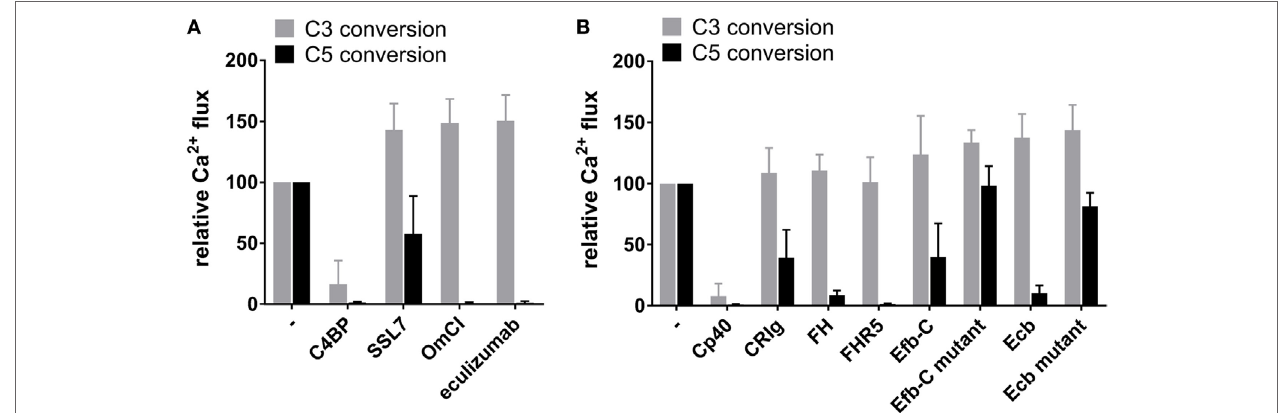
FigUre 5 | The effect of inhibitors on classical pathway C3 and C5 conversion. Conversion of C3 (50 nM) or C5 (2.5 nM) in the CP model in the absence or presence of 1 µM complement-binding molecule measured by calcium mobilization in U937-C3aR and U937-C5aR cells, respectively. Conversion is shown as a percentage relative to the control without inhibitor. (a) C5-binding molecules OmCI and eculizumab inhibit CP C5 but not C3 conversion. SSL7 inhibits C5 conversion, as well, but less efficiently. C4b-binding protein (C4BP) inhibits both CP C3 and C5 convertases. (B) None of the C3b-binding molecules, except for Cp40, affect CP C3 conversion, whereas all inhibit C5 conversion. Mutant Efb-C and mutant Ecb are unable to bind C3b and thus do not exhibit inhibition. (a,B) Data of three independent experiments, presented as mean ±